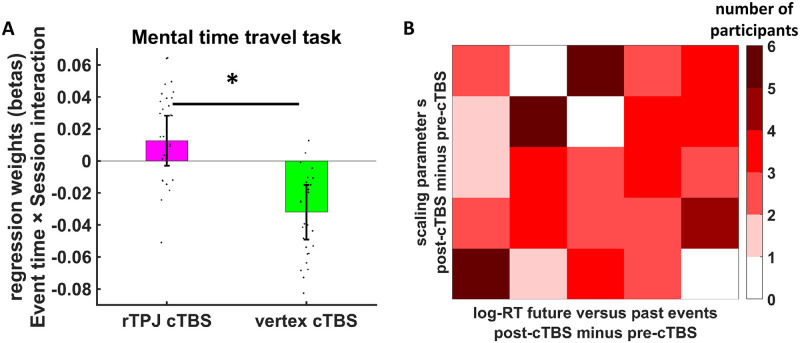
Effects of rTPJ cTBS on mental time traveling.(A) rTPJ, relative to vertex, cTBS, increased the post-cTBS minus pre-cTBS difference in RT (log-RT) for judging future relative to past events. Error bars indicate standard error of the mean. Black dots show individual parameter estimates (based on random effects estimates). Asterisks indicate significant effects (p < 0.05). (B) Heatmap illustrating the correlation between cTBS-induced post-cTBS minus pre-cTBS changes in the mental time-travel task (binned log-RT difference between events in the relative future and relative past) and the intertemporal choice task (binned scaling parameter s from generalized hyperbolic discounting). Darker colors indicate a higher number of participants in a given cell. Note that the darker colors locate primarily around the diagonal, illustrating the correlation between the cTBS effects in the two tasks. The underlying data for this Figure can be found in S1 Data. CHF, Swiss francs; cTBS, continuous theta-burst stimulation; fMRI, functional magnetic resonance imaging; RT, response time; rTPJ, right temporoparietal junction.